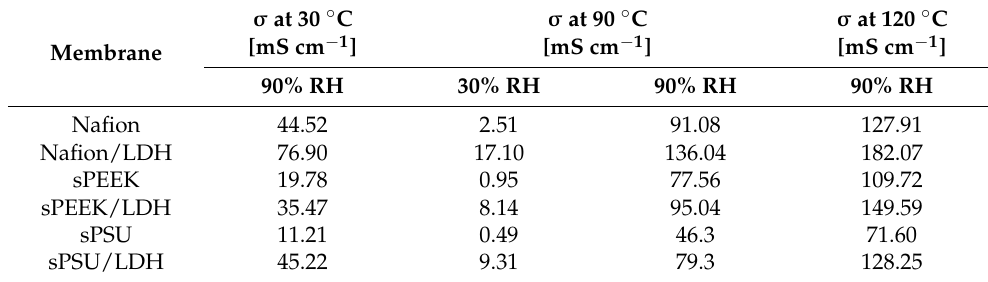
Figure 7. T 1 -relaxation times as a function of the temperature (from 20 °C to 120 °C) of the water confined in ( a ) Nafion-based, ( b ) sPEEK-based and ( c ) sPSU-based membranes. Table 2. Conductivity values at two representative temperatures (i.e., 30 and 120 ◦ C) and humidifica- tion conditions (30 and 90% RH) for the various